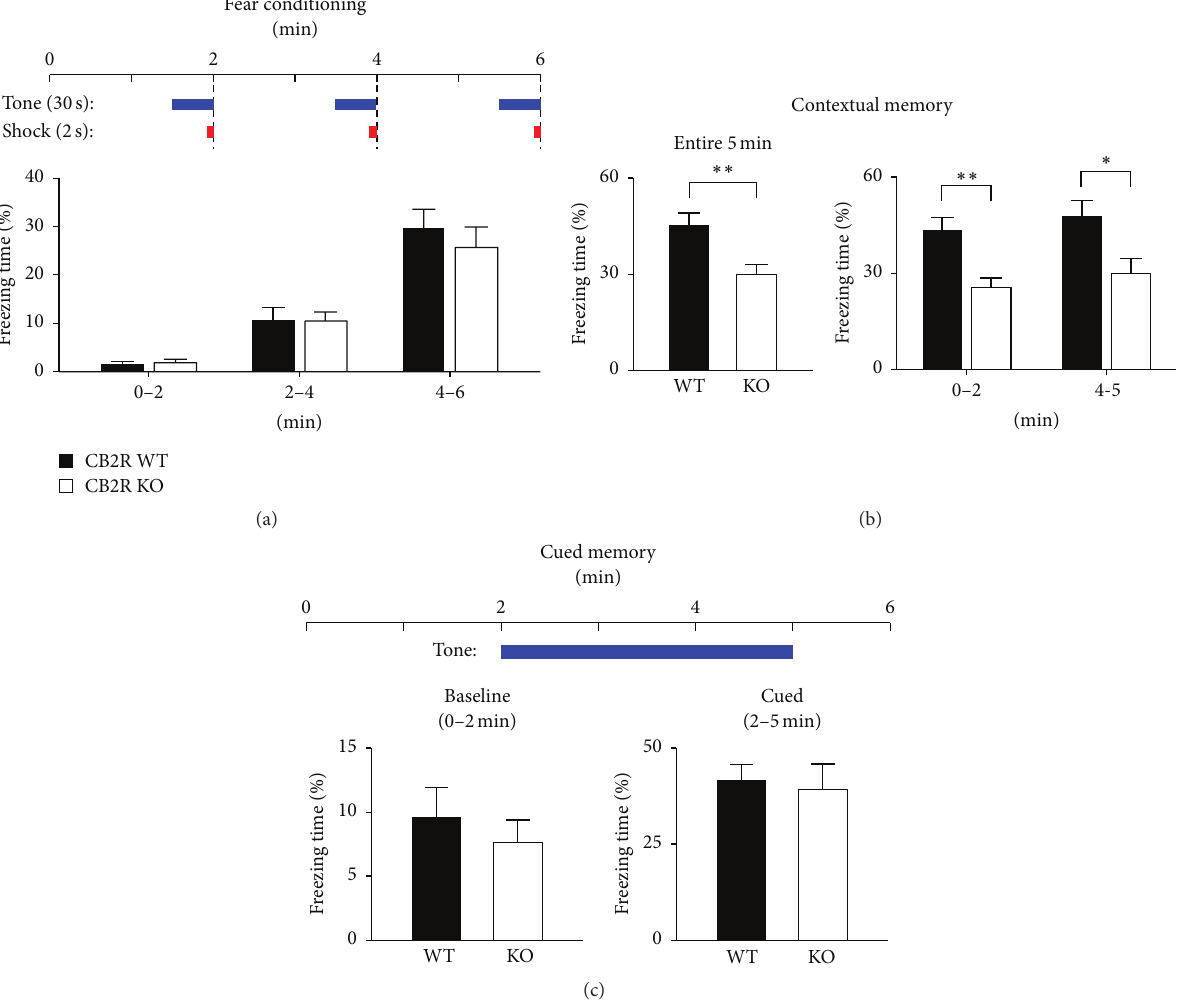
Figure 1: Contextual, but not cued, fear memory of CB2R KO mice is impaired. (a) Baseline freezing behavior of mice during the conditioning period. A mouse in a fear conditioning chamber was presented with a tone for 30 s, 3 times every 2 min. During the last 2 s of the tone, an electric foot shock was delivered. The freezing time of KO mice was similar to that of WT mice in each of the 2 min periods. (b) Contextual fear memory was tested 24 h after the fear conditioning. Mice were placed in the same conditioning chamber for 5 min and the freezing time was measured. The freezing behavior was also analyzed in the early (0–2 min) and late (4-5min) phases of the 5 min period. ∗∗ 𝑃 < 0.01 ; ∗ 𝑃 = 0.02 ; 𝑡 -test. (c) Cued fear memory was assayed after the contextual memory test in a modified conditioning chamber. A tone was presented for 3min and the freezing behavior was monitored before (for 2min) and during the tone. Error bars represent